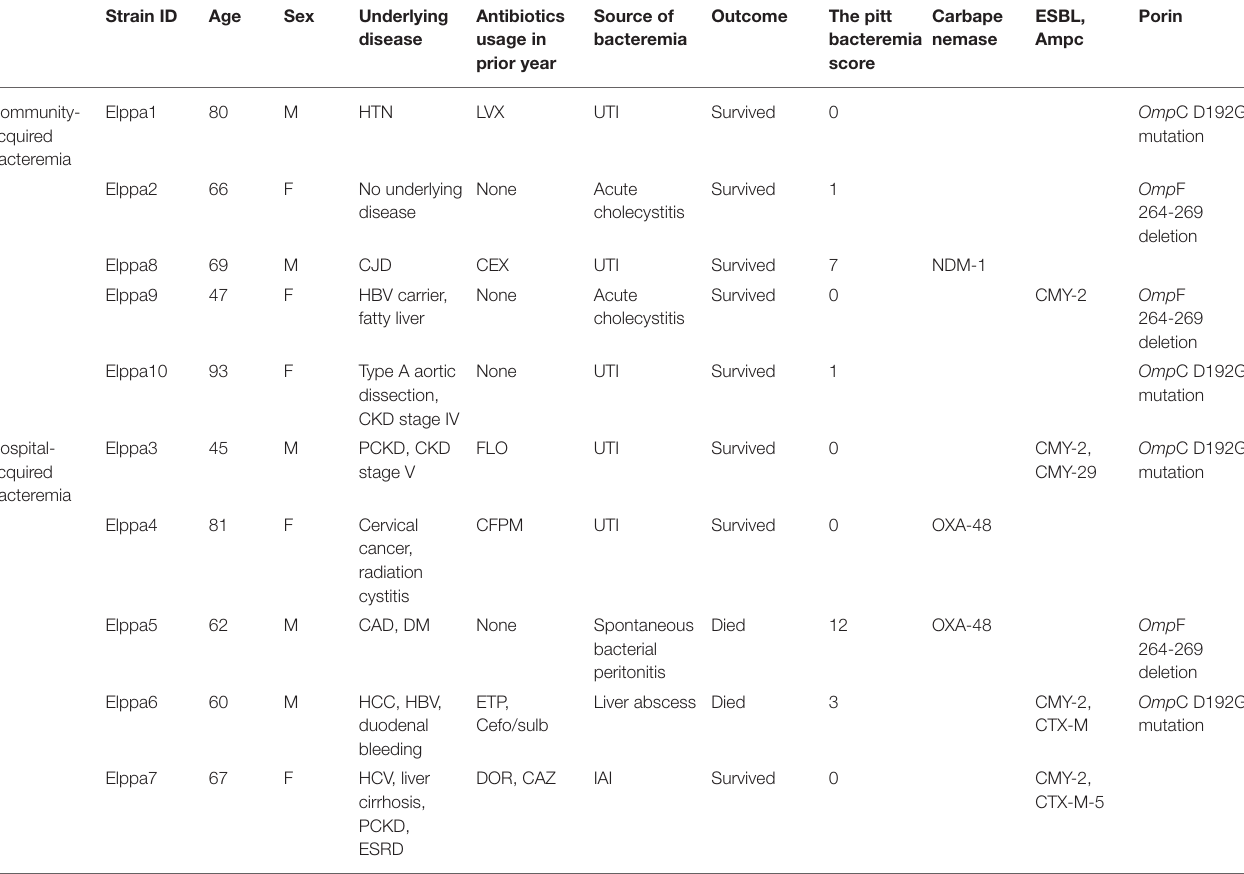
TABLE 1 | Demographic and genetic data for the 10 E. coli isolates from Central Taiwan. Strain ID Age Sex Underlying